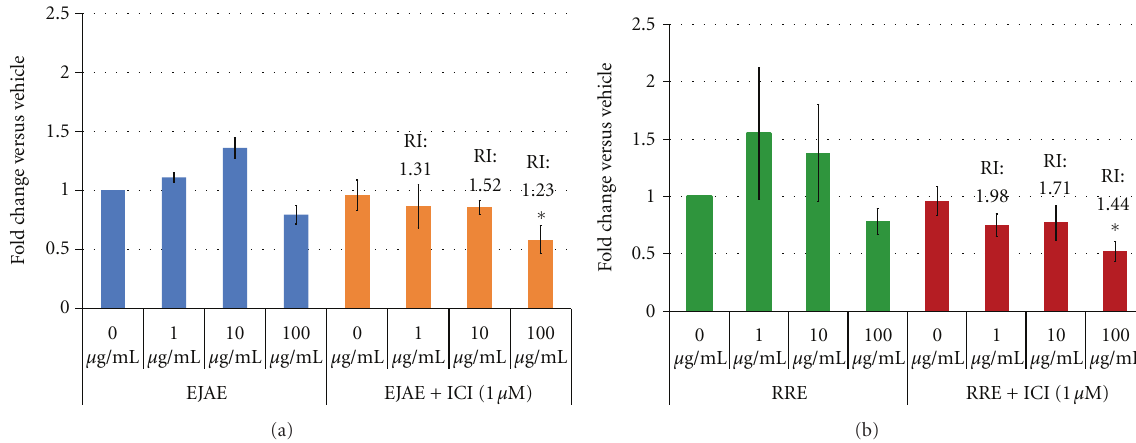
Figure 3: E ff ect of berry extracts proliferation on ICI-resistant (ZR75-1R) cell line without and with ICI. Cell proliferation results from 6 d treatment of RRE on ZR75-1R. Vehicle treatment contained 0.01% EtOH and 0.1% DMSO. All treatments (including ICI) were normalized to the appropriate vehicle treatment. Data represented is mean ± standard error of three individual experiments performed in triplicate for each treatment. The means were tested for di ff erence using a t -test and a P ≤ 0 . 05 considered significant. The significantly di ff erent means compared to vehicle control ( # ) or ICI-only treatment ( ∗ ) are indicated. The relative index (RI) was calculated using the formula RI = S (expected)/ S (observed) = S [ a ] × S [ b ] /S [ a + b ], where a and b , are extract and ICI, respectively [28]. An RI = 1 was considered additive, < 1 antagonism or absence of synergism, and > 1 presence of